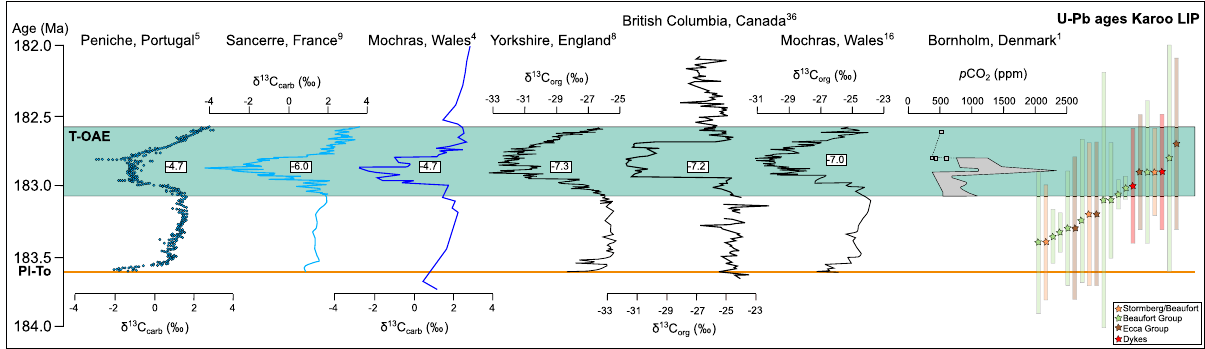
Fig. 2 Correlation between Toarcian carbon cycle perturbations and the timing of Karoo intrusions. Timeline of Karoo activity, the Toarcian Ocean Anoxic Event (T-OAE; green box), carbon isotope curves from shallow marine stratigraphic sections and p CO 2 data (including uncertainties) after ref. 18,19,35 . The age of the Pliensbachian-Toarcian (Pl-To) boundary (orange line) is from ref. 19 . U-Pb ages of Karoo intrusives are from ref. 18 – 21 . U-Pb color codes refer to sill emplacement levels in the Karoo Basin, and corresponds to the colors used in the map and cross section in Fig. 1. Numbers in boxes